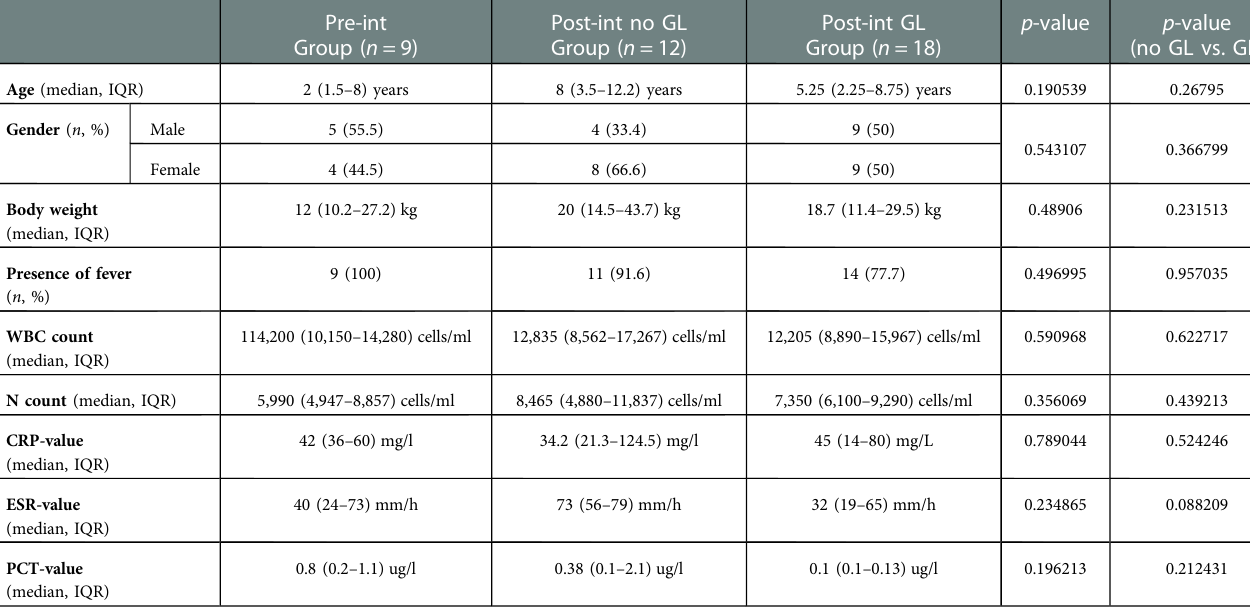
TABLE 5 Characteristics of patients with SA at